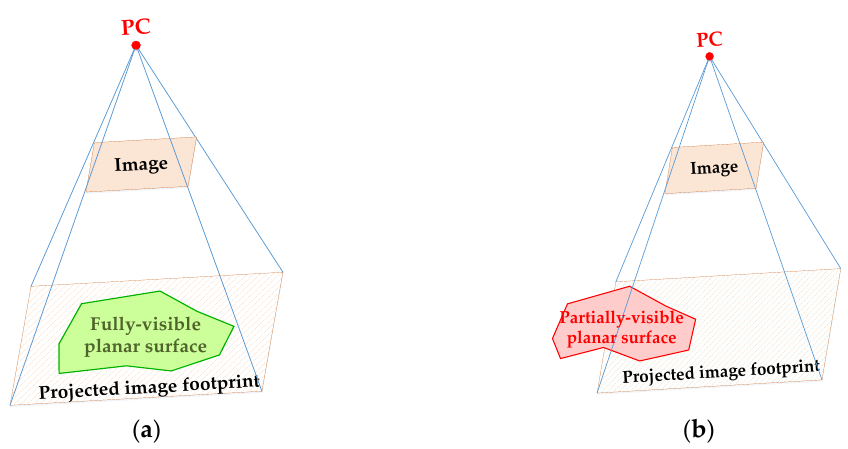
Figure 8. Representation of ( a ) a fully visible and ( b ) a partially visible planar surface in an